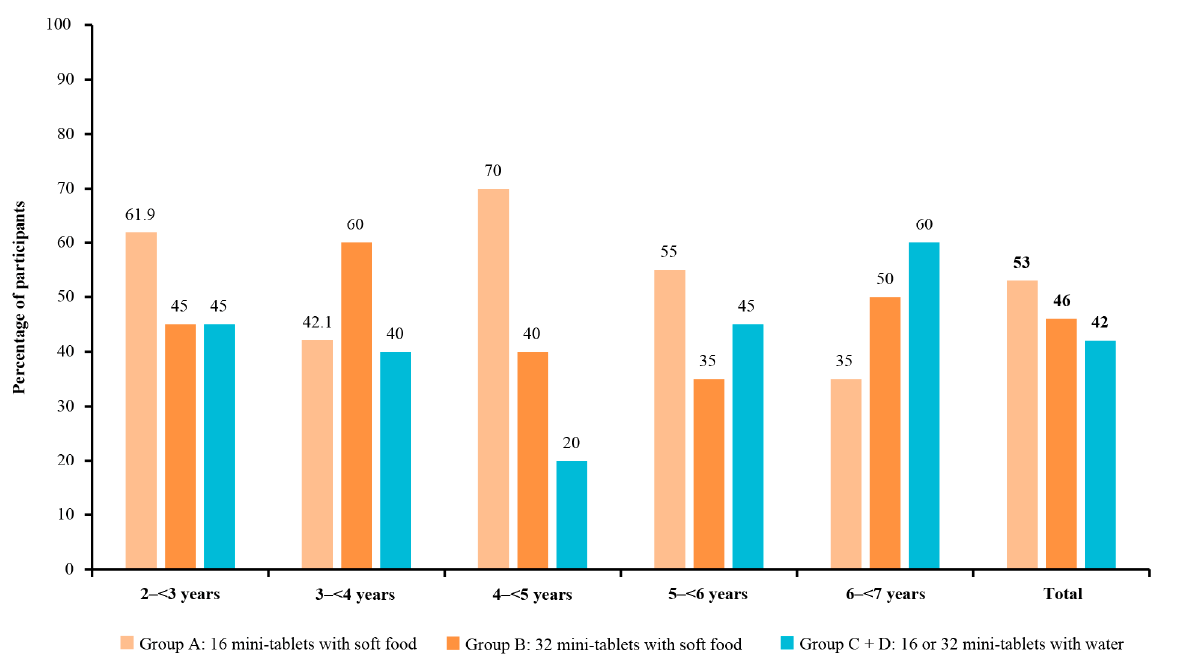
Figure 5. Swallowability of 3 mm placebo mini-tablets by age group. Swallowability was defined as swallowing all of the mini-tablets without chewing, with no residuals of the mini-tablets found in an oral inspection.